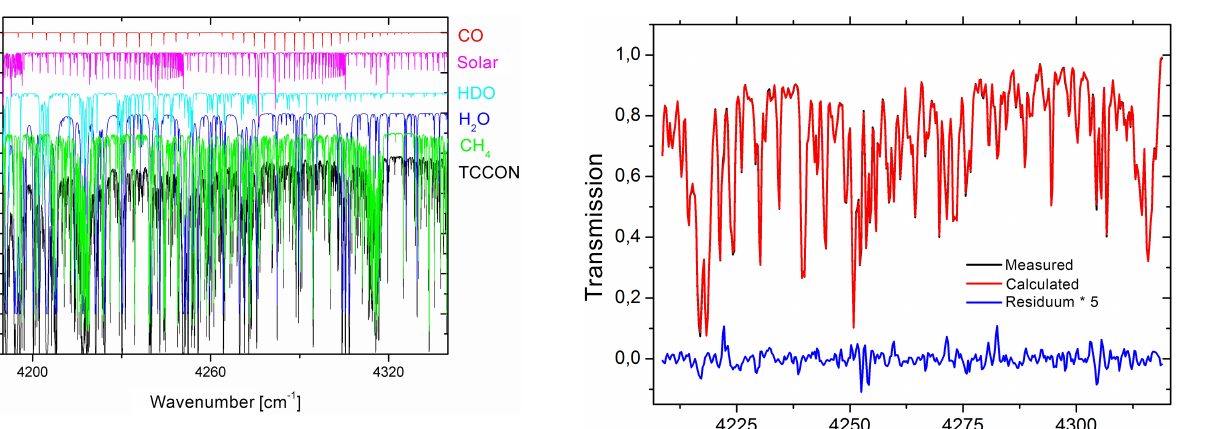
Figure 6. Spectrum simulated for TCCON resolution showing the relevant absorption features in the spectral region under considera- tion. Figure 7. Typical spectral fit for the selected CO fitting region (4210–4320cm − 1 ) . Interfering species are CH 4 , H 2 O, and